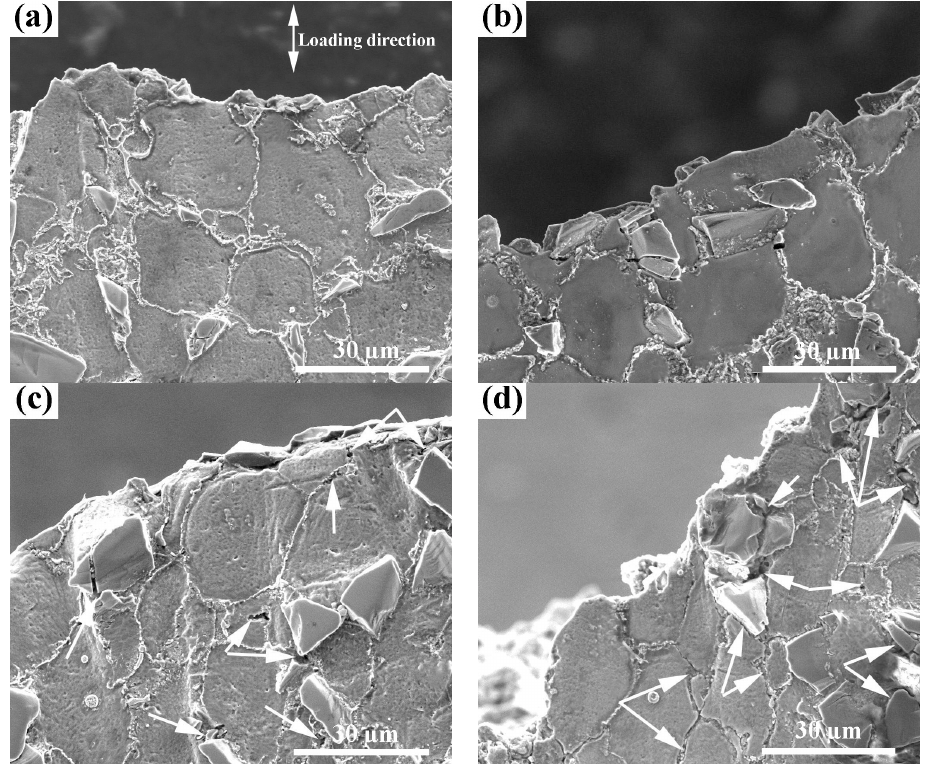
Figure 9. Side views of fracture surfaces of the composite tested at temperatures of ( a ) 25 °C; ( b ) 200 °C; ( c ) 250 °C; and ( d ) 300 °C.